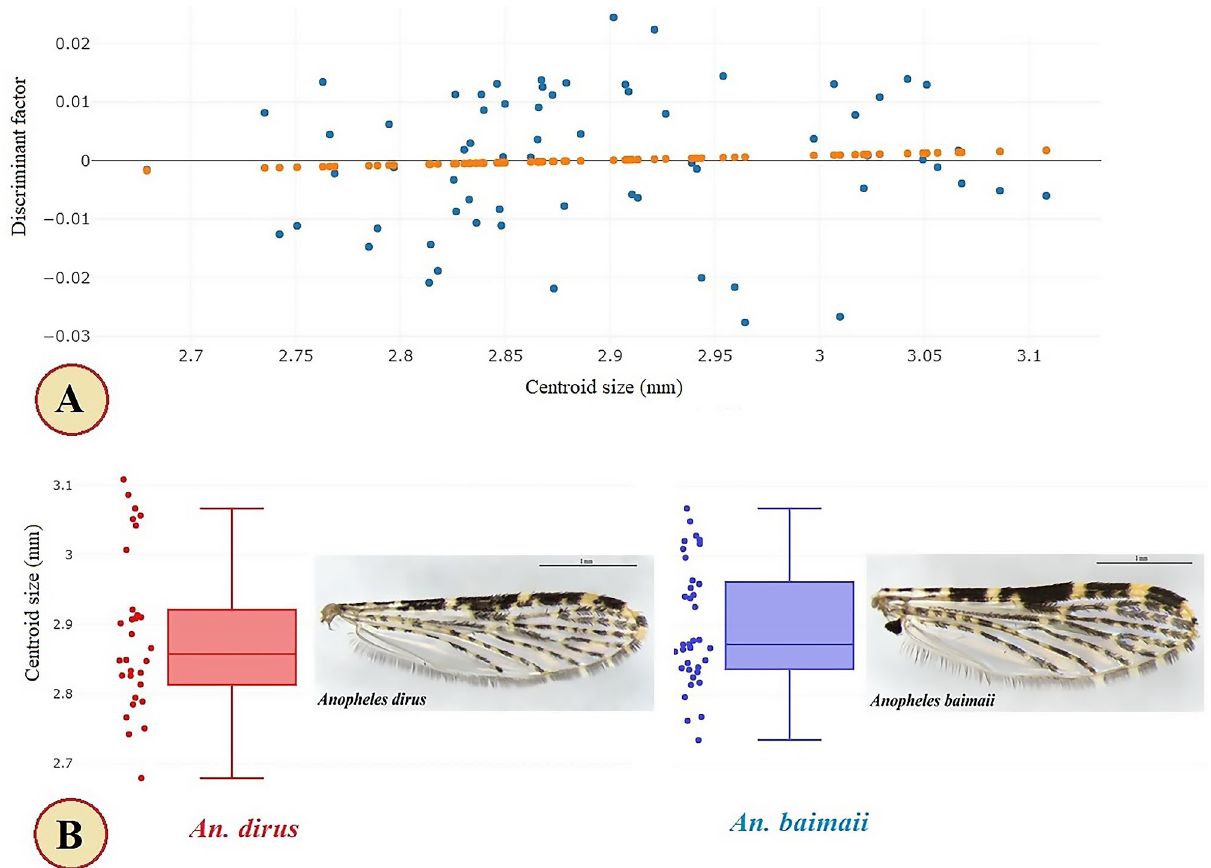
Figure 4. Scatter plot showing the linear regression prediction (orange dotted line) for examining the allometric effect ( A ), and boxplots showing the variation of wing centroid sizes (CS) of Anopheles dirus (red) and An. baimaii (blue) ( B ). Each quartile box displays the median as a vertical line across the middle and the quartiles indicating the 25th and 75th percentiles at its ends. Anopheles spp.